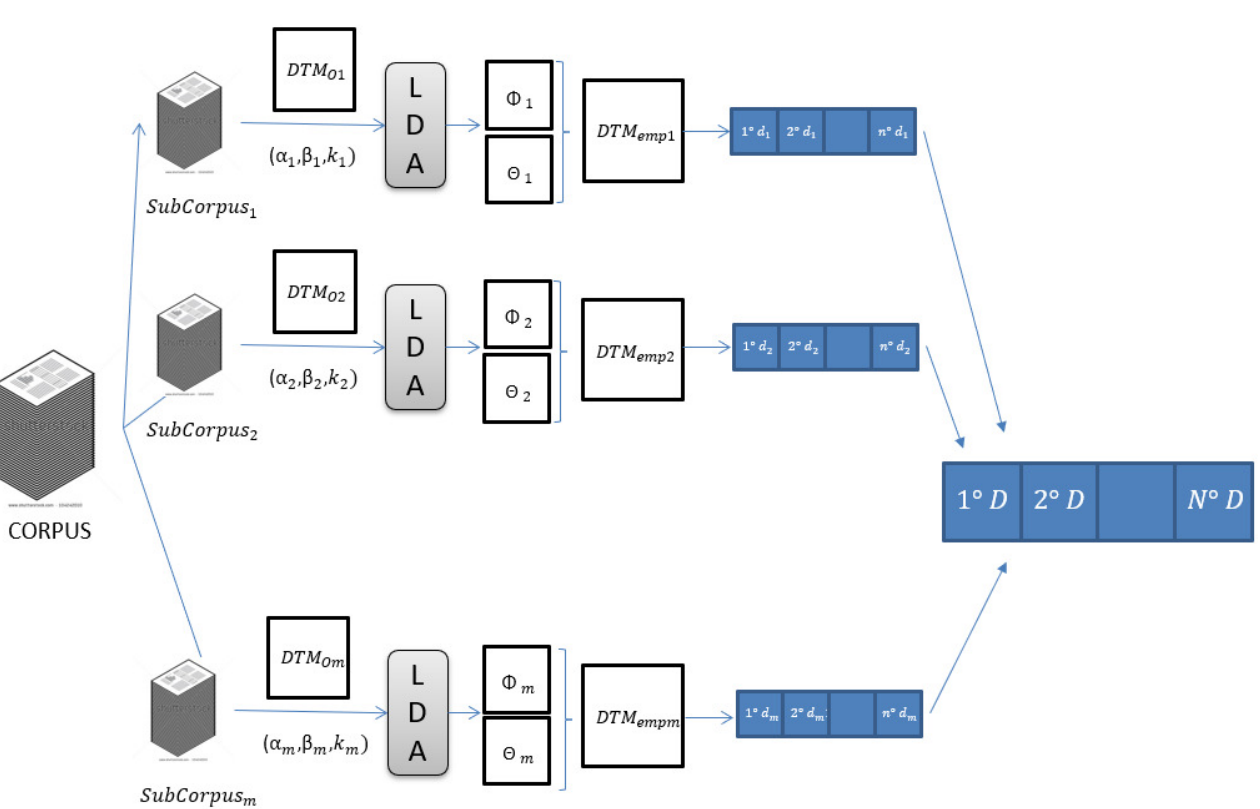
Figure 1. General scheme of the strategies studied in this work. First, the corpus is divided into m document partitions, fitting an LDA model in each of them. Then, document ranking is performed merging the ranking lists obtained from each LDA model using